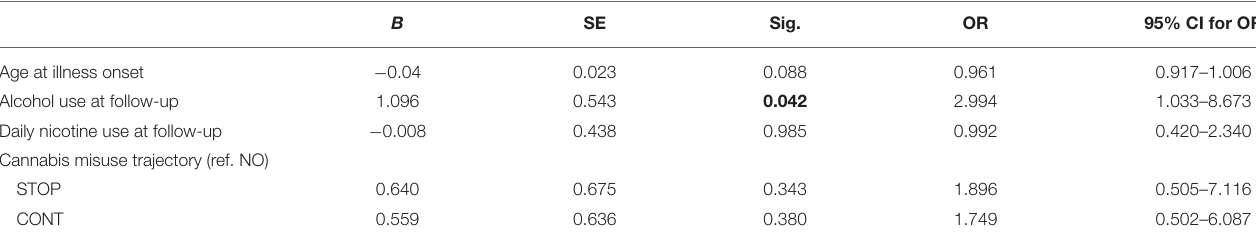
TABLE 3 | Prediction of “any relapse” with cannabis misuse